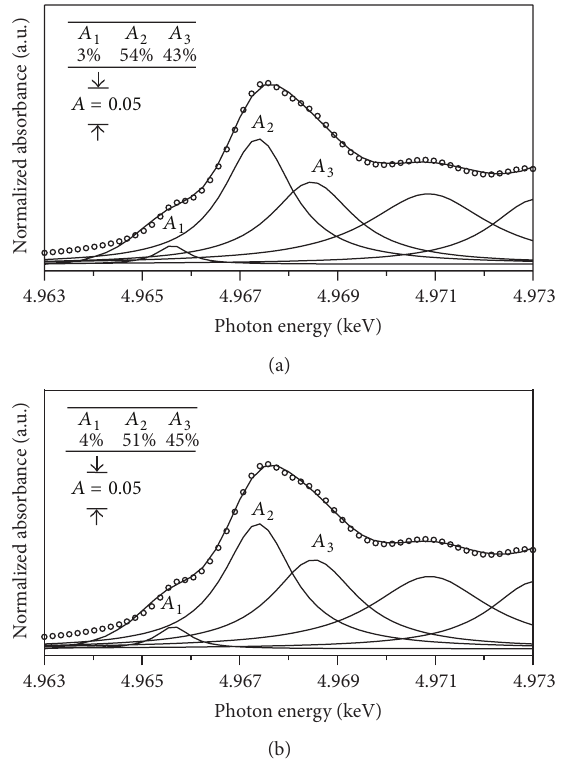
Figure 5: The Ti K-edge XANES and the Gaussian-Lorentzian deconvoluted spectra of the (a) Cu-TNT and (b) Fe-TNT. The dotted and solid lines represent fittings and experimental data, respectively.